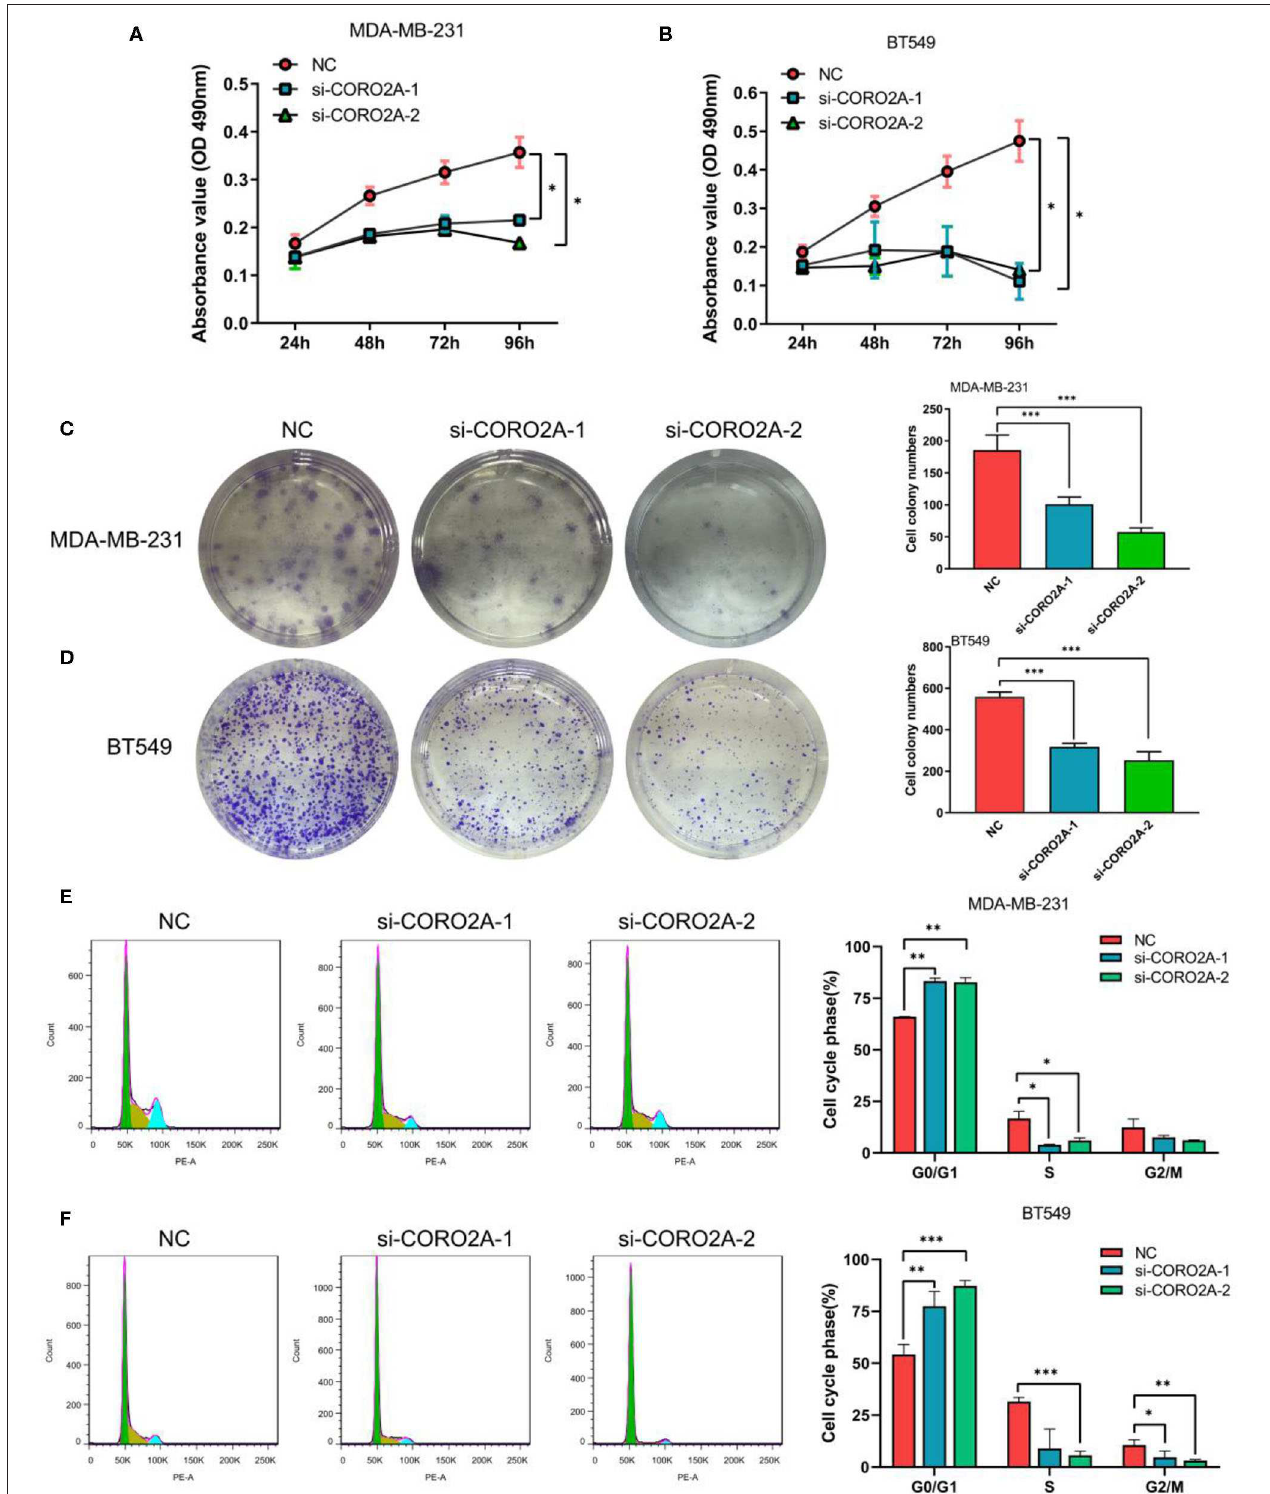
FIGURE 8 | Effect of CORO2A knockdown on cell growth was evaluated by MTS, colony formation, and cell cycle distribution assays in TNBC cell lines. (A,B) CORO2A knockdown inhibited the cell viability of MDA-MB-231 and BT549 cells. Cell viability was measured using MTS assay and the data are mean ± SEM ( n = 3) of three independent experiments. (C,D) Representative images of colony formation assay and the mean ± SEM ( n = 3) of three independent experiments of